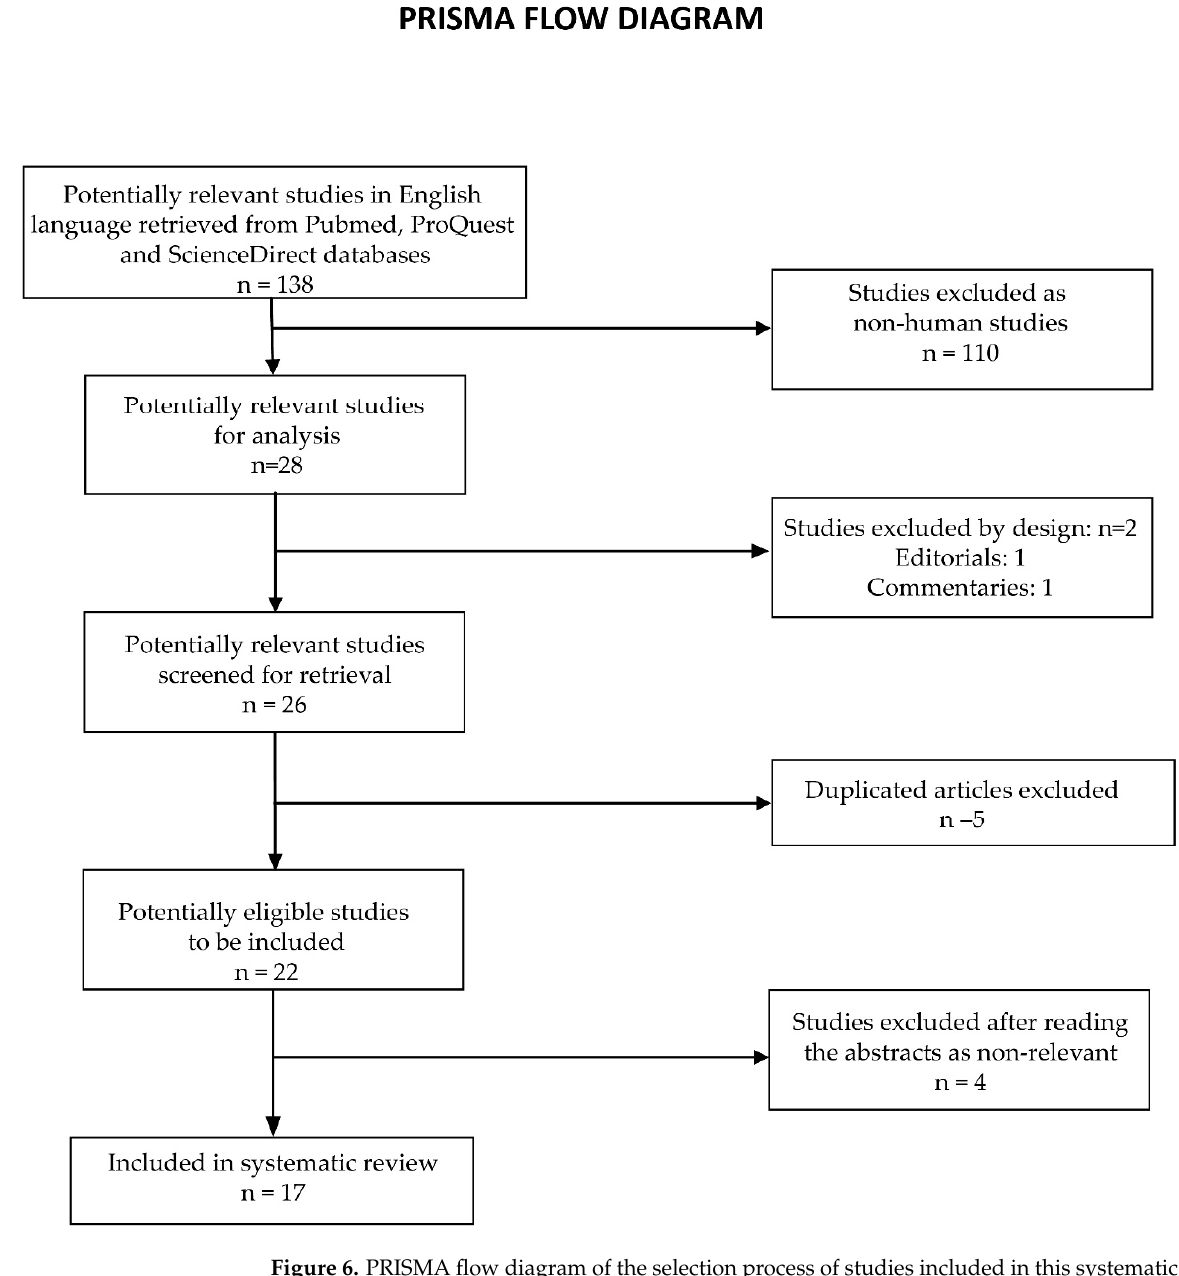
Figure 6. PRISMA flow diagram of the selection process of studies included in this systematic re- view.